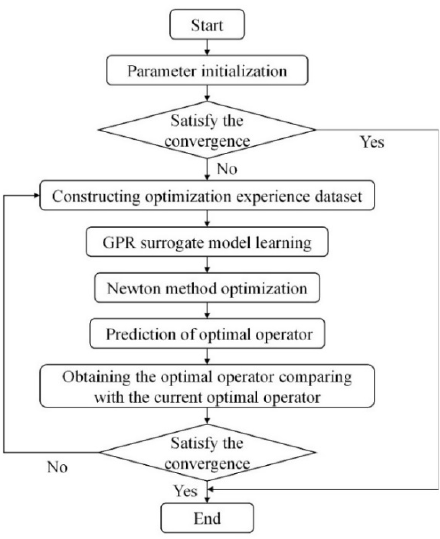
Figure 3. Flowchart of the GOA ‐ GPR optimization algorithm.